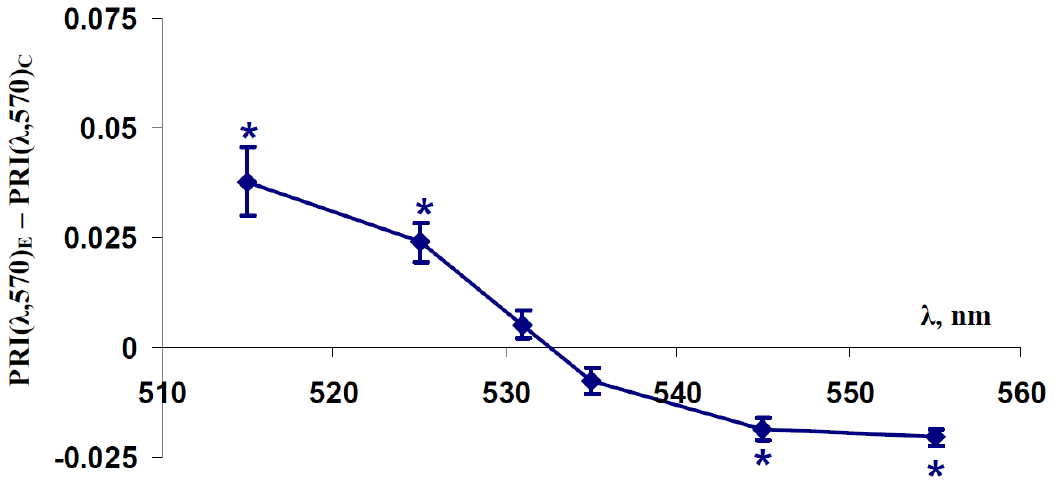
Figure 1. Dependence of difference between modified photochemical reflectance indices in leaves of pea plants under water shortage (PRI(λ,570) E ) and these indices in leaves of control plants (PRI(λ,570) C ) on wavelengths of the measuring reflected light (λ) ( n = 5 –6). PRI(λ,570) E and PRI(λ,570) C were measured after five days of water shortage. *, difference was significant ( p < 0.05). This result shows that reflectance indices based on the slow-relaxing component of reflectance changes in the green spectral region (this component was mainly at 515 and 525 nm [50]) were increased by the water shortage, and the indices based on the fast-relaxing component of these changes (this component was mainly at 535, 545, and 525 nm [50]) were decreased under water-deficient conditions.